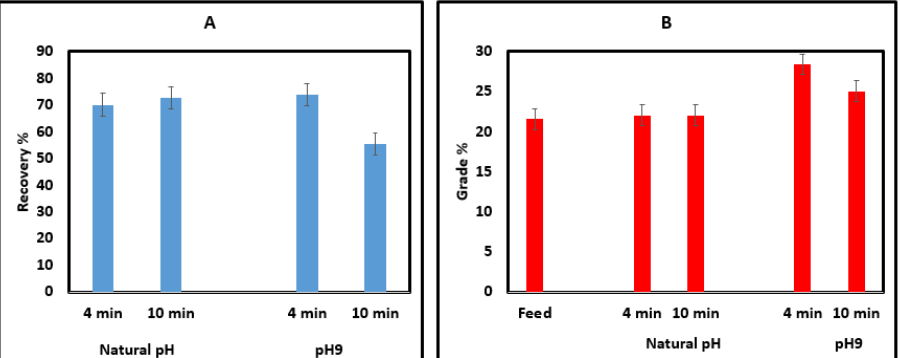
Figure 13. ( A ) Flotation recovery and ( B ) P 2 O 5 grade (%) at different pH values in the presence of sodium silicate dispersant.